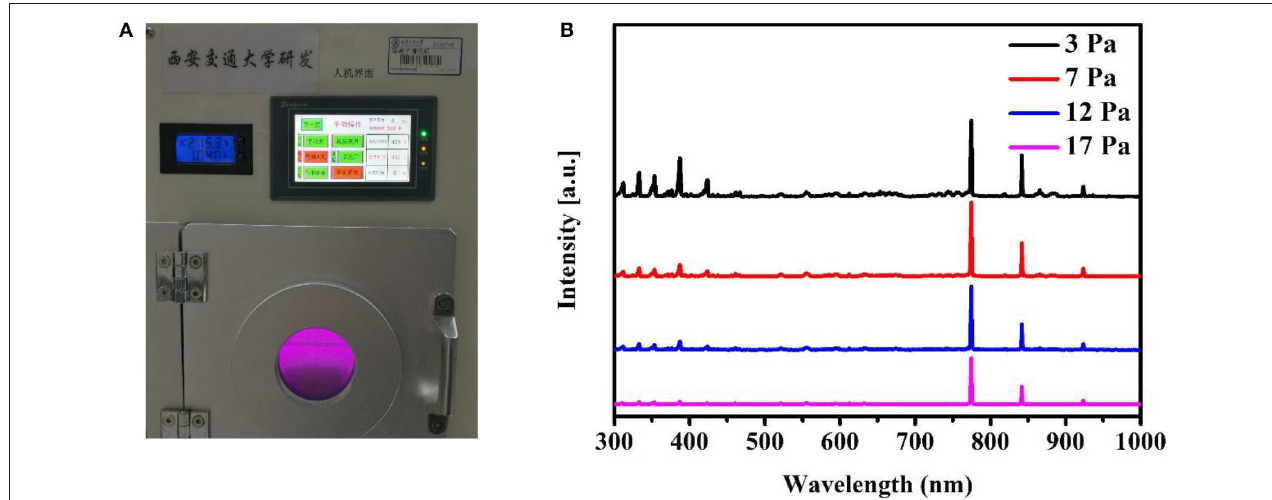
FIGURE 3 | Glow discharge generating plasma. (A) A photo of the in situ film-depth-dependent light absorption spectra (FLAS) instrument during the oxygen plasma generation. The purple area in the photo shows oxygen plasma glow discharge. (B) Emission spectra of oxygen plasma during glow discharge at different oxygen plasma pressures. The spectra are shifted along the vertical direction for clarity.